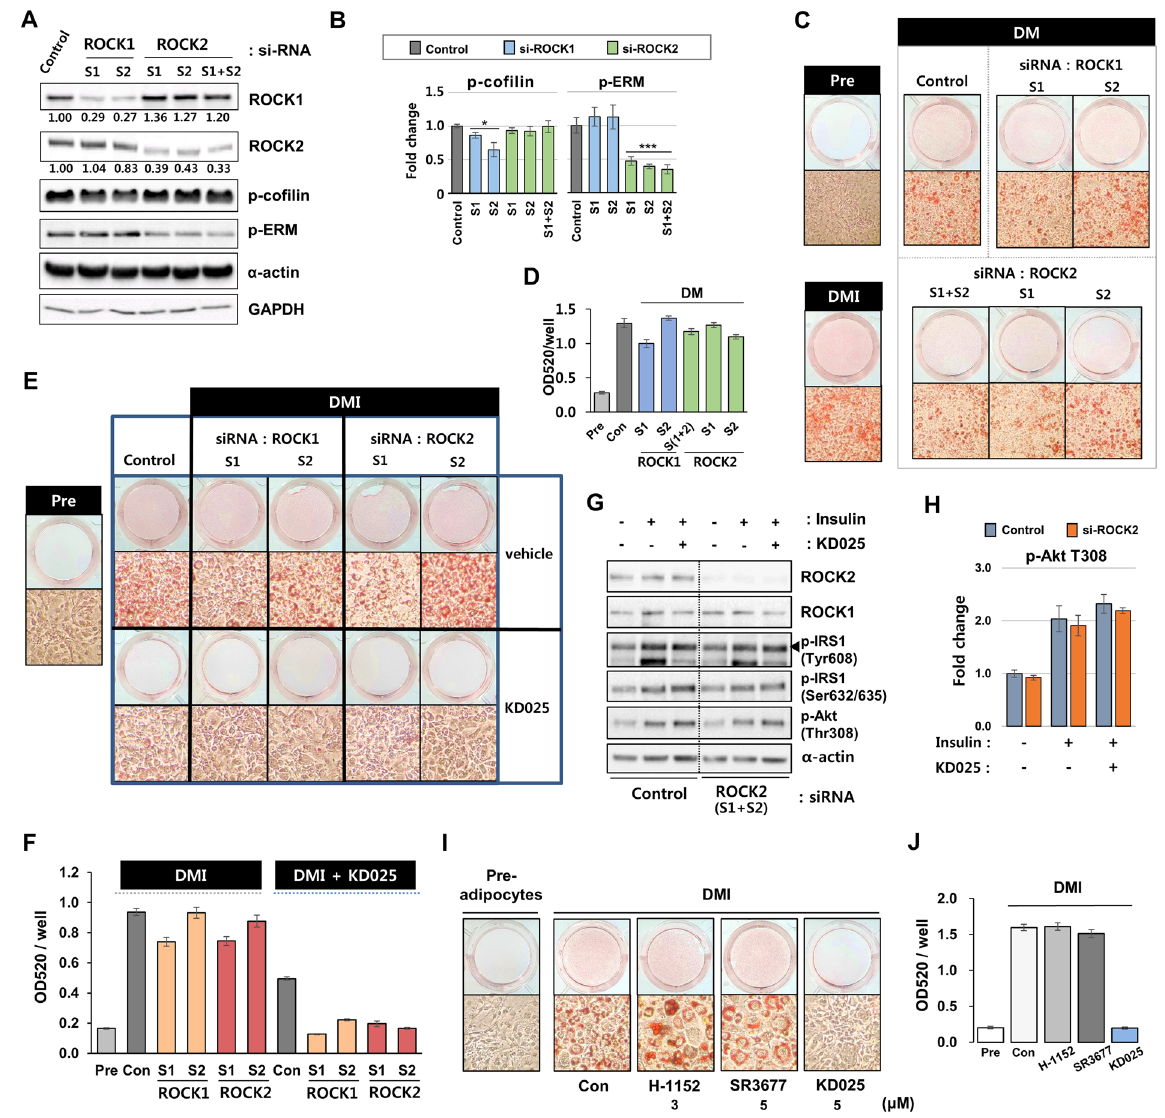
Figure 7. ROCK-independent action of KD025 on adipogenesis. ( A , B ) 3T3-L1 cells transfected with two different sequences (S1 and S2) of ROCK1 or ROCK2 siRNA and incubated for 2 days to reach confluence. ( A ) Cell lysates were subjected to SDS-PAGE and analyzed using anti-ROCK1 and anti-ROCK2 antibodies to see the depletion of each isoform. The phosphorylation levels of cofilin and ERM were measured using phospho-specific antibodies. GAPDH and α -actin were used as loading controls. ( B ) The phosphorylation level change of cofilin and ERM by gene knockdown of ROCK 1 and 2 was depicted as fold changes. * p < 0.05; ** p < 0.01; *** p < 0.001 vs . vehicle-transfected. ( C and D ) Transfected cells were grown to confluence and maintained for 2 days and then differentiated through incubation with DM-containing medium for 8 days. ( C ) Cells were stained with Oil Red O. Macroscopic and microscopic pictures of cells are shown. ( D ) Lipid accumulation was assessed by measuring absorbance at 520 nm of Oil Red O. ( E – G ) Transfected cells with ROCK siRNAs were differentiated through incubation with DMI for 8 days with or without KD025 (5 µ M). ( E ) Cells were stained with Oil Red O. Macroscopic and microscopic pictures of cells are shown. ( F ) Lipid accumulation was assessed by measuring absorbance of Oil Red O. ( G , H ) Insulin signaling pathway was inspected with lysates from ROCK2 knocked-down pre-adipocytes cells (S1 + S2) with or without KD025 treatment. Immunoblot analysis was undergone with antibodies for phospho-IRS-1 (Tyr608 and Ser632/635), phospho-Akt (Thr308), Akt, ROCK1, and ROCK2. α -actin was used as a loading control. The relative level of p-Akt (Thr308) was assessed as fold changes compared to insulin-/KD025-untreated control cells. ( I , J ) The effect of H-1152 and SR3677, potent ROCK inhibitors, was analyzed on 3T3-L1 differentiation. ( G ) Cells were stained with Oil Red O and microscopic images are displayed. ( H ) Lipid accumulation was assessed of Oil Red O. The data are the representative from more than three independent experiments. Data are expressed as means ± S.E. based on